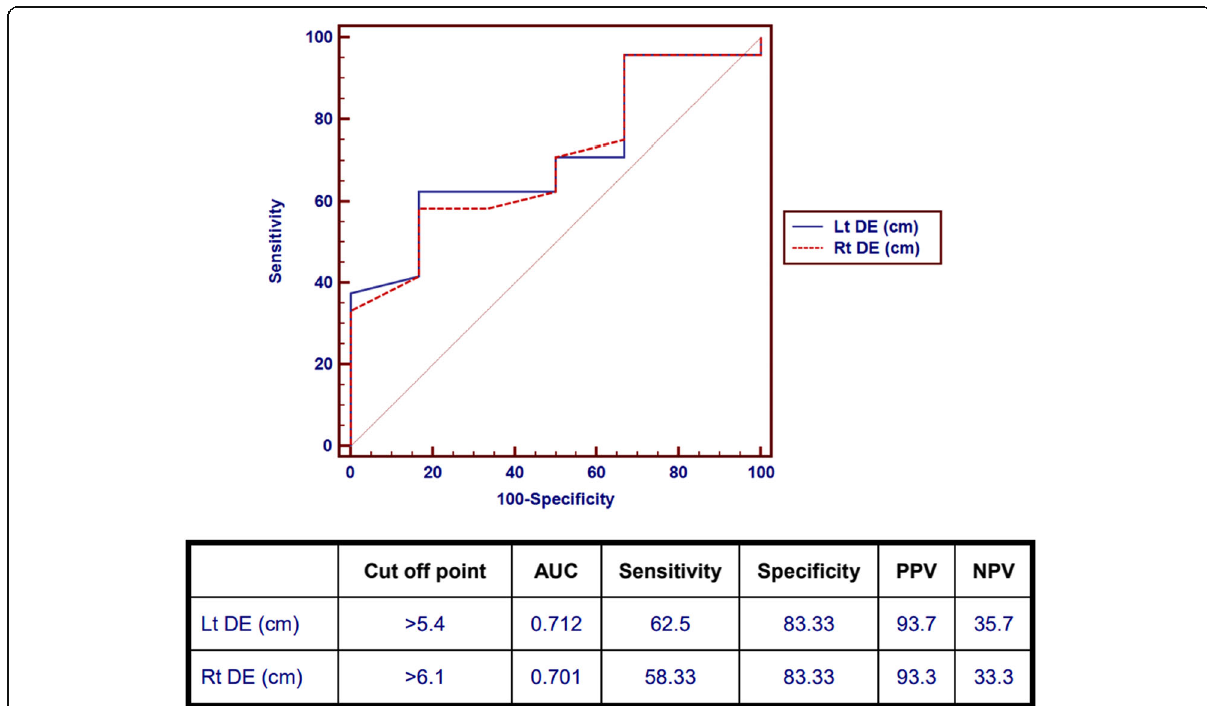
Fig. 6 Receiver operating characteristic curve (ROC) for diaphragmatic excursion to differentiate between successful weaning and weaning